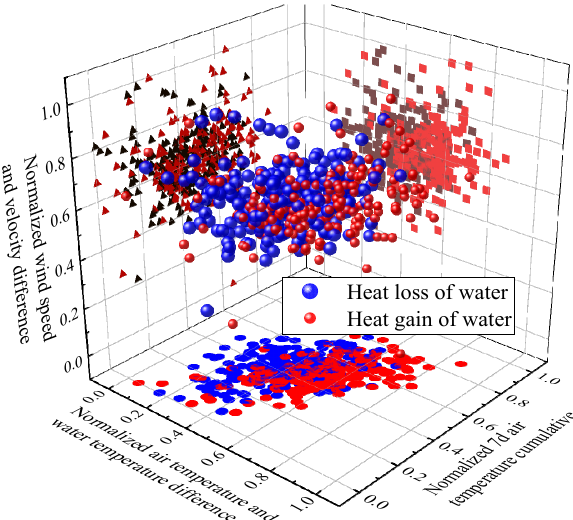
Figure 3. Standardized influencing factors and water heat budget analysis.